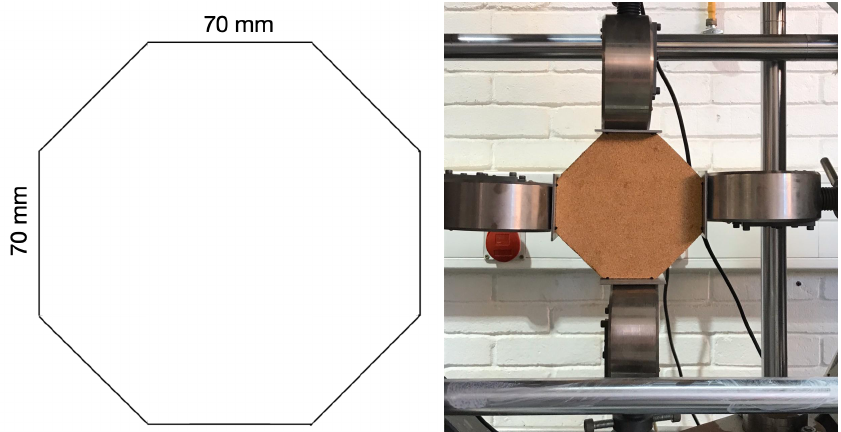
Figure 4. Dimensions of the octagon-shaped sample and the experimental setup for the equibiaxial compression